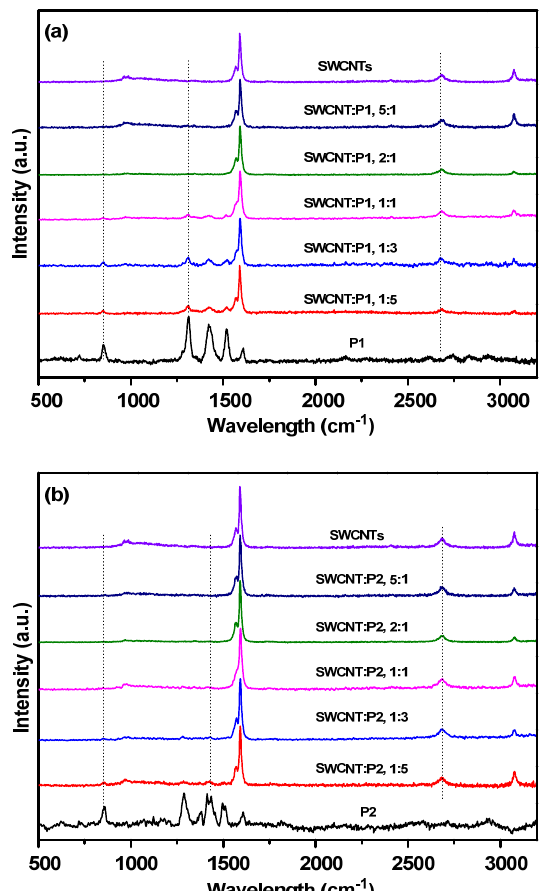
Figure 4. Raman spectra of ( a ) P1 / SWCNTs composites and ( b ) P2 / SWCNTs composites films with di ff erent amounts of SWCNTs.